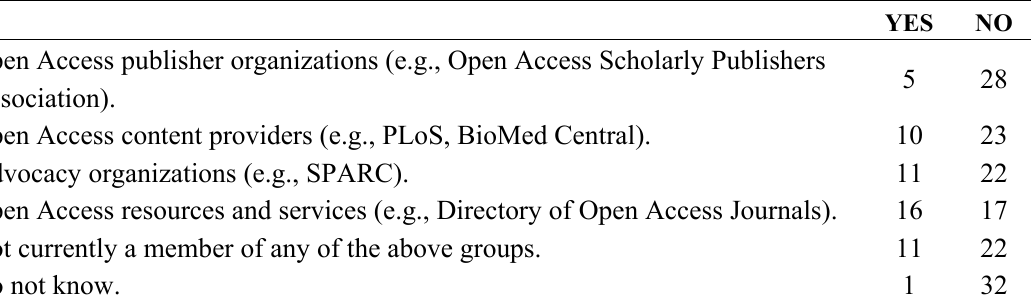
Table 3. Membership in OA